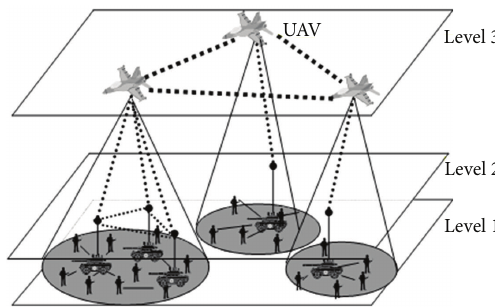
Figure 1: Multilevel UAV heterogeneous ad hoc wireless network